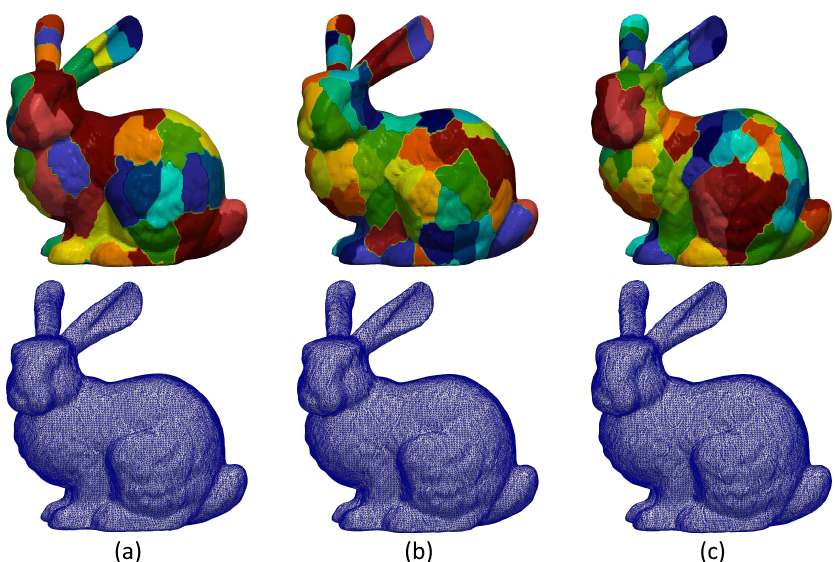
Figure 1. ( First line ) Segmentation of bunny model using MeTis algorithm in ( a ) 70, ( b ) 100 and ( c ) 200 parts. ( Second line ) The corresponding reconstructed models without applying overlapping process (edge effect is apparent).